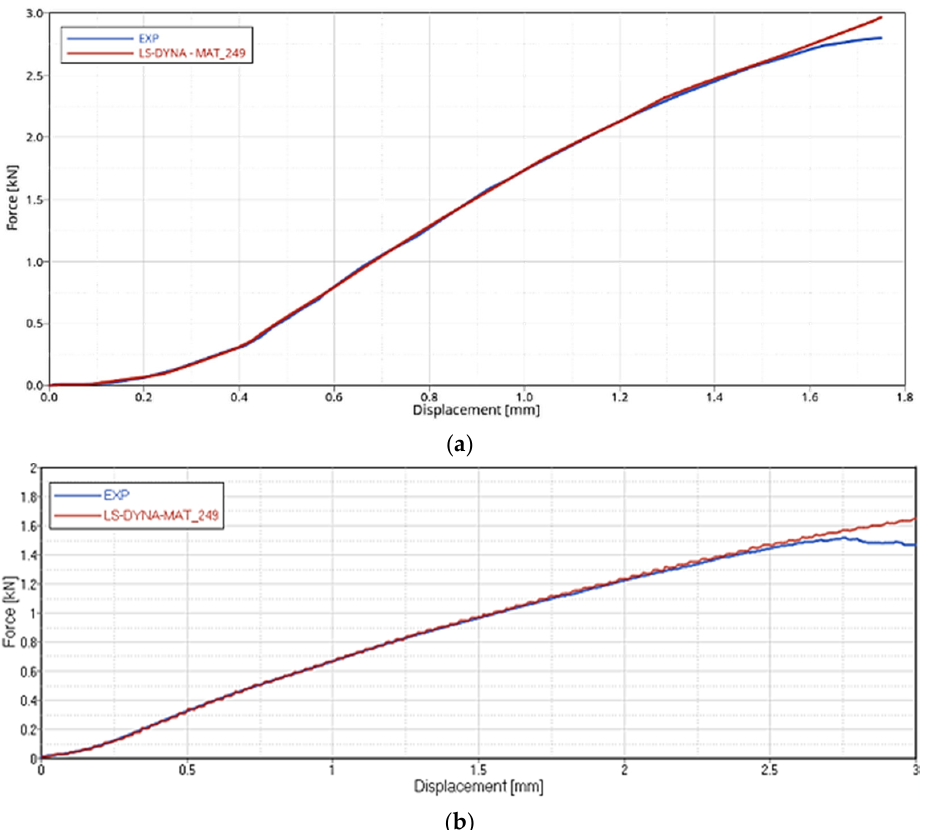
Figure 24. FEA-experimental correlation of the Tensile test on GF ( a ), CF ( b ) dry fabrics.